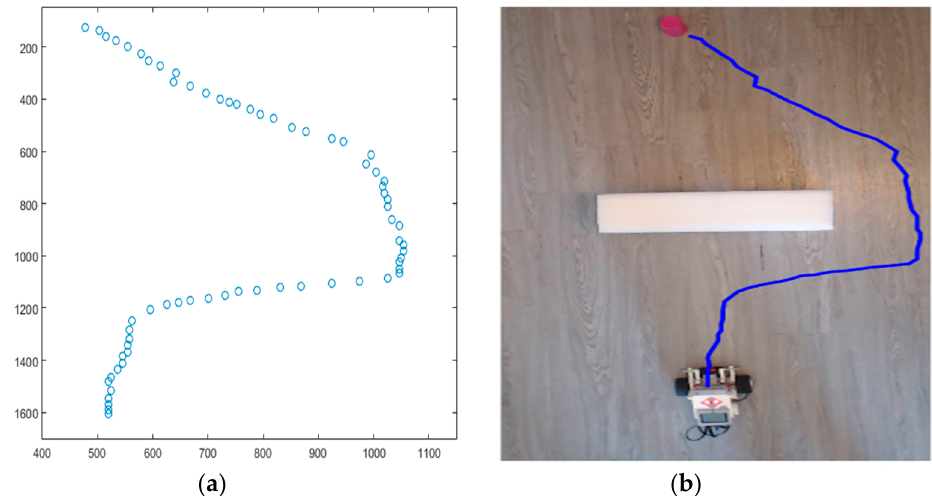
Figure 19. Robot trajectory from the experiment of Figure 14 (1. Scenario). ( a ) Inputs (Gaze Coordinate); ( b ) robot path trajectory.